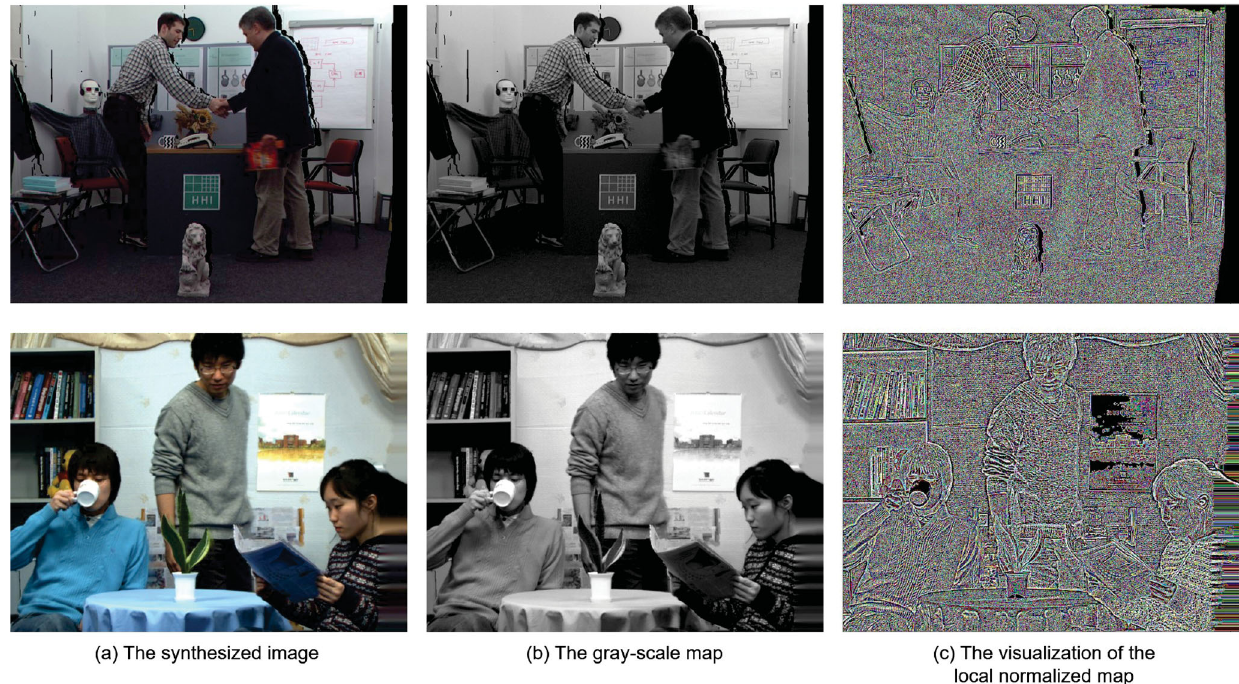
Fig. 5 Visual perception of synthetic images. (a) Two synthetic images. (b) Corresponding gray-scale maps. (c) Visualization of the local normalized maps [15, 17]. Note that holes in regions with high intensity contrast and complex textures are lost after gray-scale transformation and local contrast